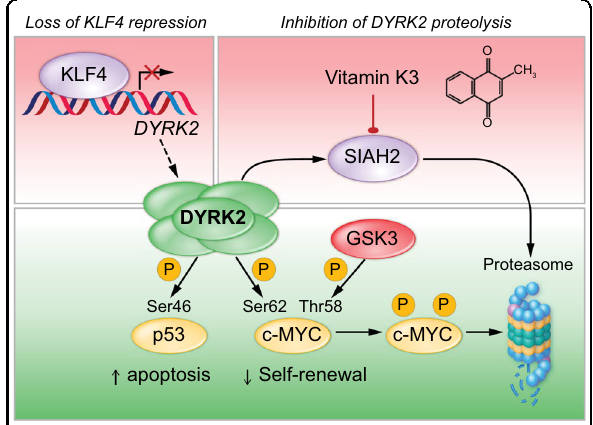
Fig. 3 The kinase DYRK2 promotes the survival and inhibits the self-renewal of LSCs. DYRK2 has emerged as a novel target to eradicate CML LSCs. DYRK2 mediates p53 activation and c-MYC proteasomal degradation through phosphorylation. DYRK2 expression is regulated genetically by the transcriptional repressor KLF4 and by SIAH2-mediated proteasomal degradation. Pharmacological inhibition of SIAH2 with vitamin K3 (VK3) induces dose-dependent cytotoxicity associated with DYRK2 stabilization, p53 activation, and c-MYC depletion. Treatment of murine and human CML cells with VK3 has shown proof of concept that modulation of the DYRK2 protein with small molecules is a novel approach to eradicate LSCs.